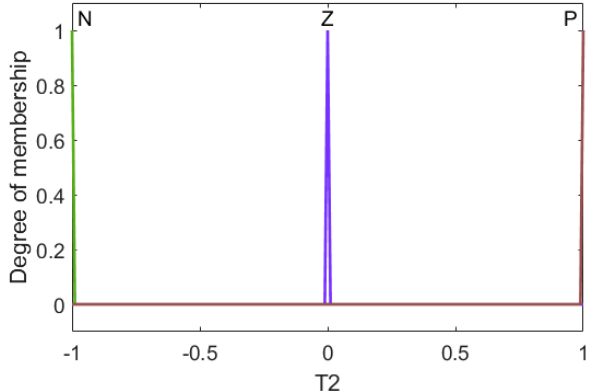
Figure 8. Output T2, not optimized.